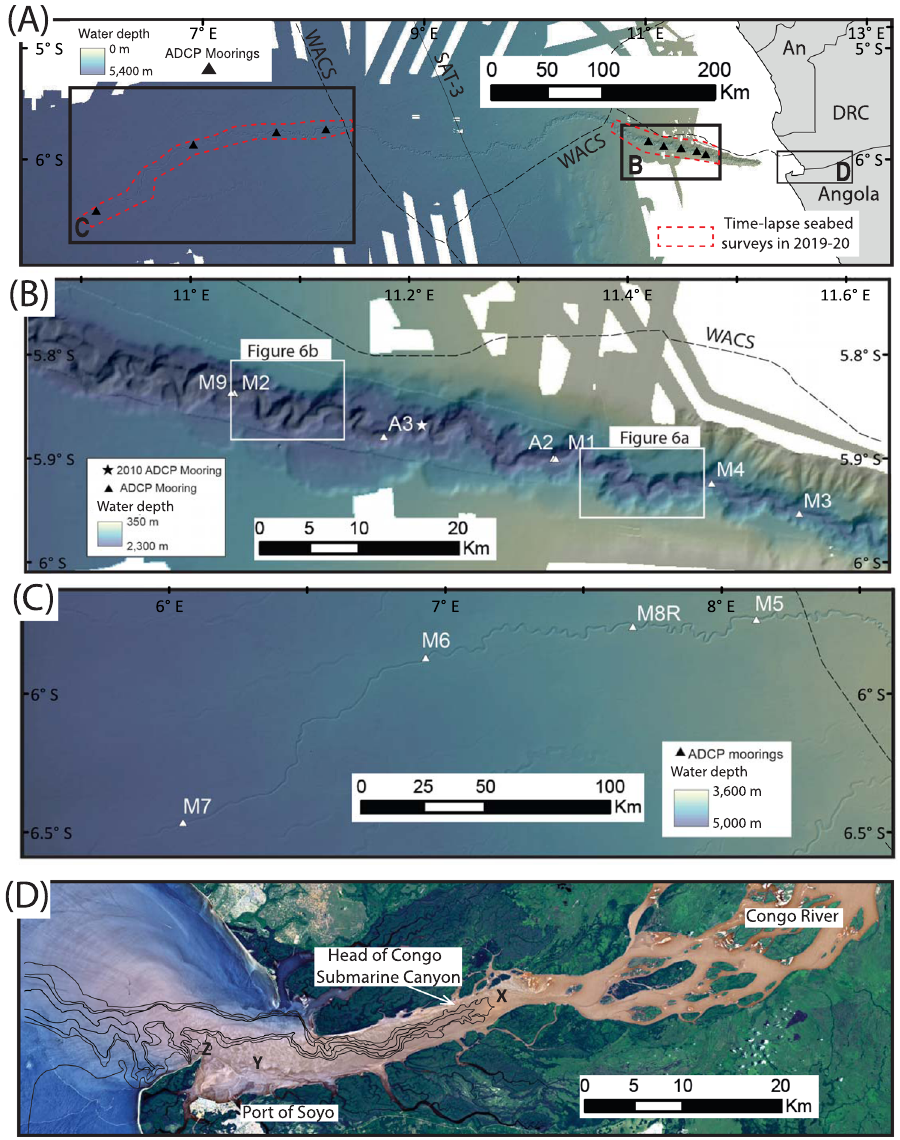
Fig. 1 Location map of oceanographic moorings and telecommunication cables that recorded turbidity currents in 2019 – 21 in the Congo Canyon and Channel, offshore from the mouth of the Congo River in West Africa. A Map of the entire array with mooring (e.g., M1 or A2) and cable (e.g., WACS) names. Red dotted lines indicate areas where time-lapse bathymetric surveys were collected in September – October 2019 and October 2020. B , C Detailed map of the upper submarine canyon, and deep-water submarine channel, with locations in A . D The head of the Congo Submarine Canyon lies within the estuary forming the mouth of the Congo River, with the river producing a surface plume of sediment that extends offshore. Landsat 8 image on 02-03-2015 with superimposed bathymetric contour at 20, 100, 200, and 400m from UK Admiralty Chart 658. The main submarine canyon head (x), a shallow-water plateau off Soyo (y), and tributary canyon heads (z) are